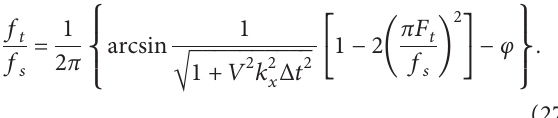
imaginary value actually. That is to say, at those frequencies propagating waves in the discrete case. To illustrate the deviation more clearly, the comparisons between (26) and (28) at two different wavenumber points are shown in Figure 3. Here the flow velocity represented as the Mach number is given as M � 0 . 6, and the sampling frequency is chosen as 12.8 kHz. From Figure 3, the deviation of tran- sition frequency can be observed, and it is more apparent at a higher wavenumber point. It is expected that the correction can be made by assuming that f t / f s equals 􏽥 f t / f s , and